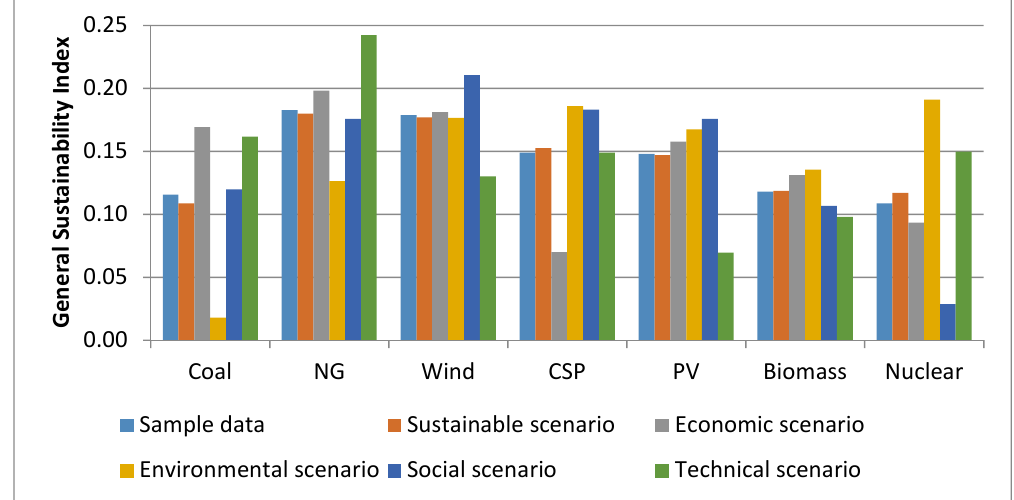
Figure 10. The general sustainability index of the technologies for the six assessed scenarios. Table 10. Ranking of the technologies in the six scenarios.